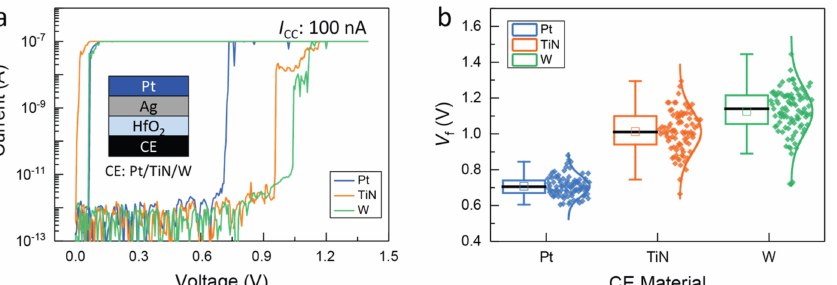
Figure 3. ( a ) Representative I-V curves of the forming of Ag/3 nm HfO 2 /CE devices for the three different CE materials Pt, TiN, and W. ( b ) Box plot displaying forming voltage ( V f ) collected from 96 cells for Pt, TiN, and W devices. A compliance current ( I CC ) of 100 nA and a sweep rate of 6.25 mV/s were used for the measurements.